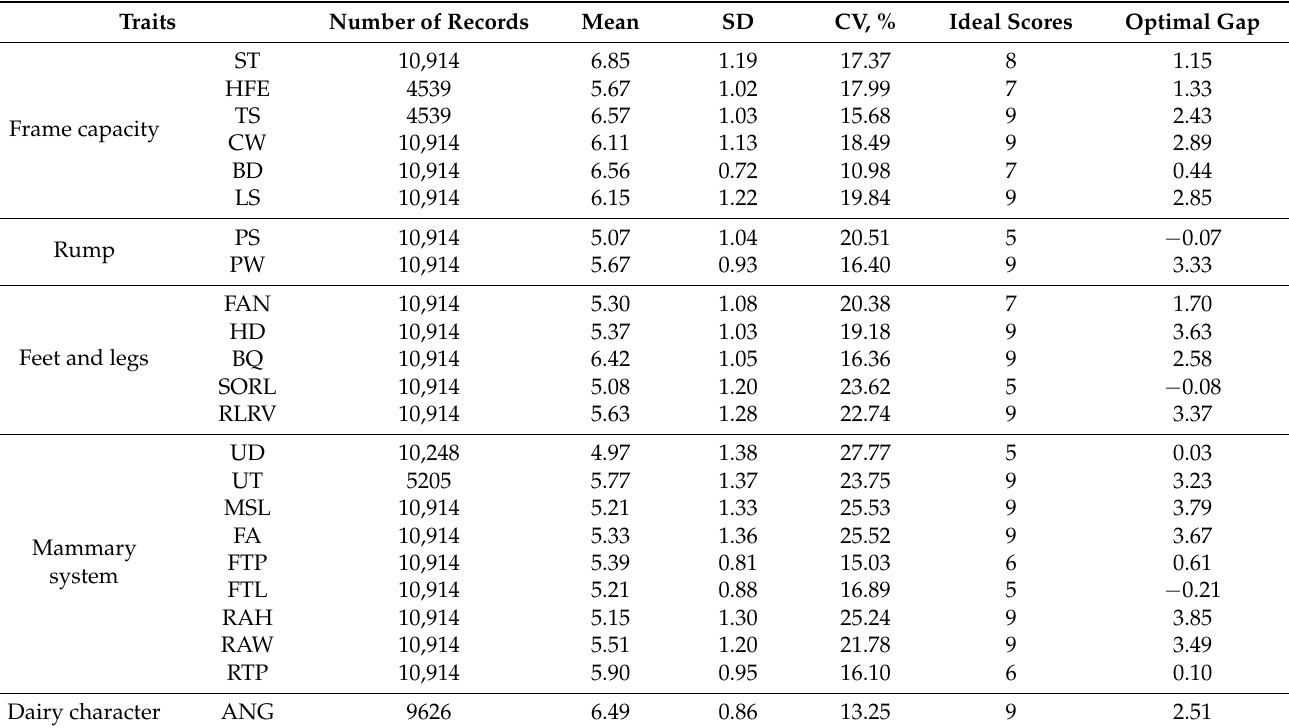
Table 2. Descriptive statistics for conformation traits in Chinese Holsteins 1 .